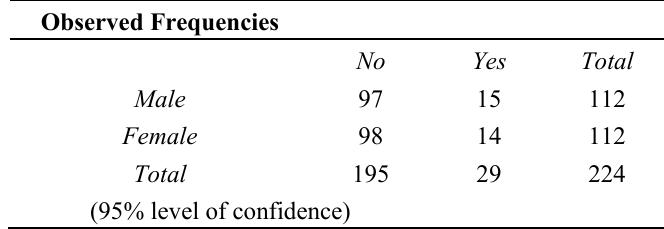
Table 4. Cross tabulation analysis between gender and escape or